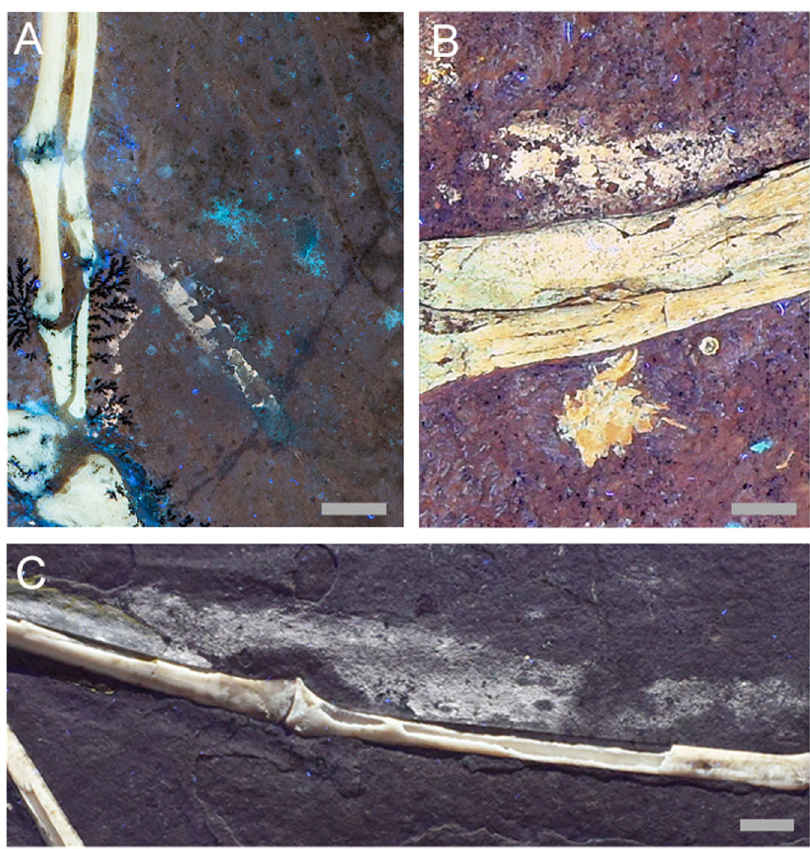
Fig. 2 Comparison of preserved organic tissues in Solnhofen fossils. a Feather sheath from WDC-CSG-100. b Skin preservation on Juravenator JME Sch 200 (Jura Museum Eichstätt). c Wing membrane preserved in an undescribed pterosaur from the Jura Museum Eichstätt (JME SOS 2016). Scale bars: a , 0.5 cm, b 4 mm, and c 1 cm.